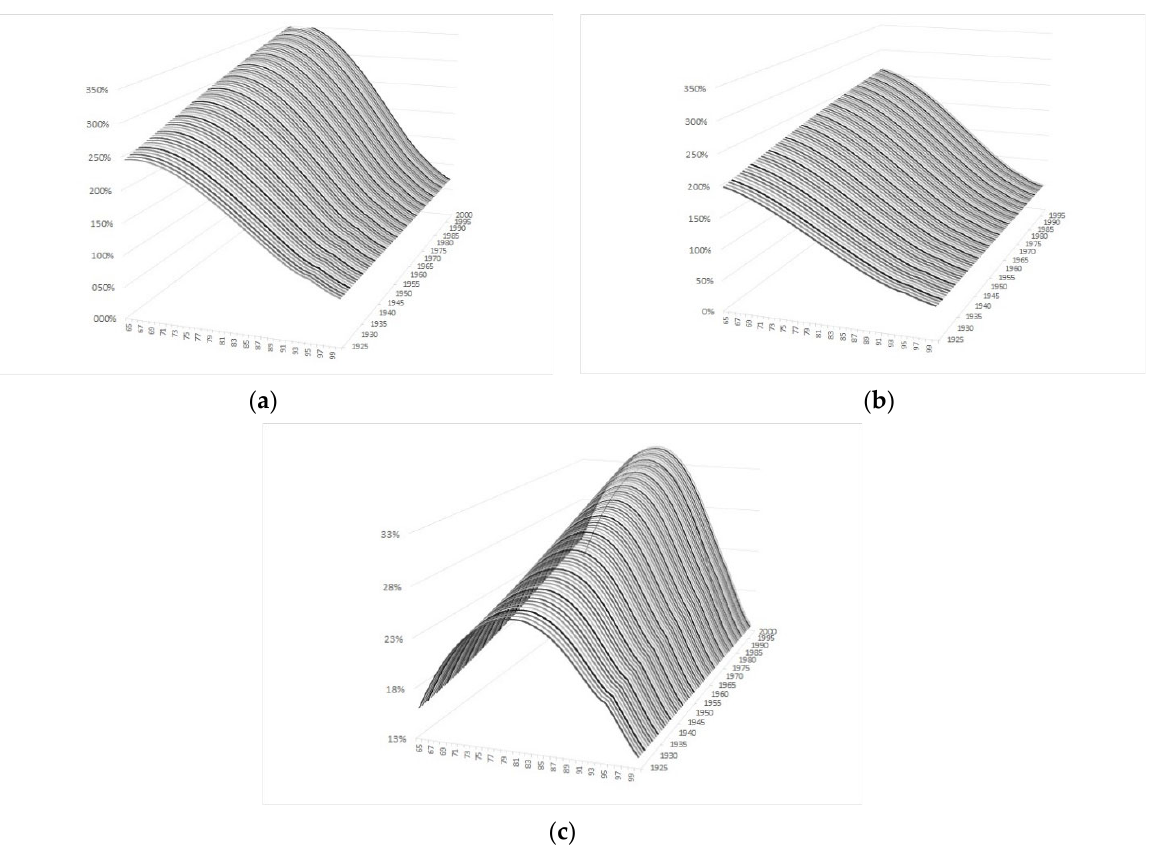
Figure 5. Actuarial retirement equity factor. Percentage of LTC supplement by age and gender. ( a ) Men; ( b ) women; ( c ) effect of gender on the percentage of LTC by age. Source: Own work. Software used: Microsoft Excel.